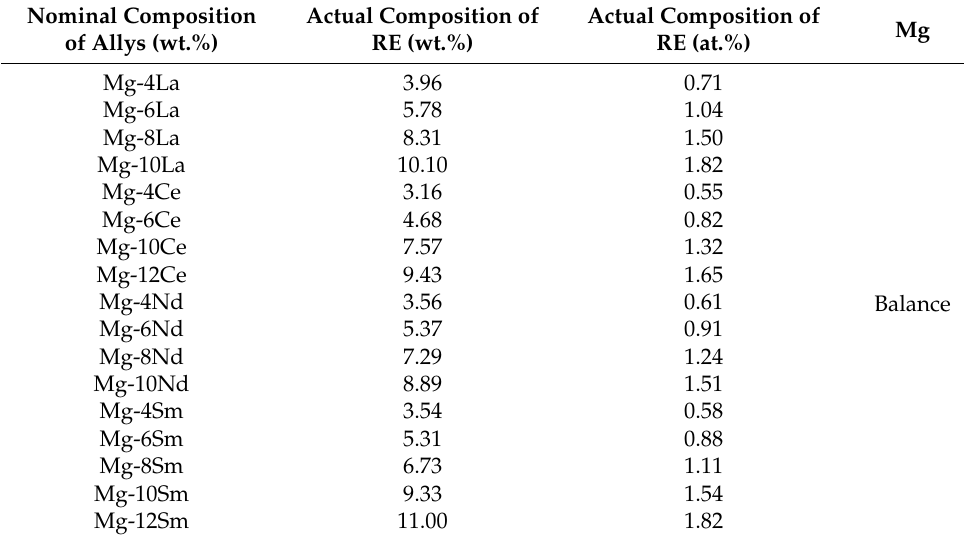
Table 1. Compositions of Mg-RE binary alloys. Nominal